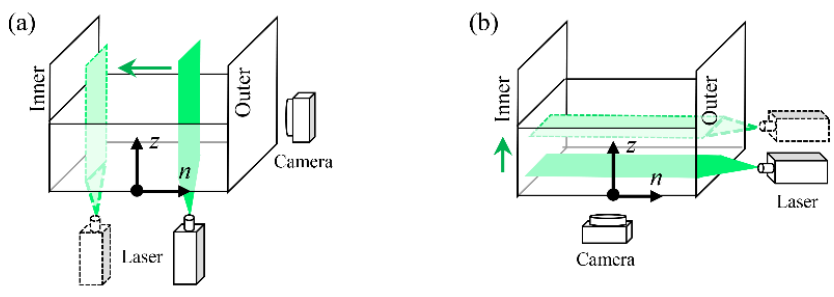
Figure 2. PIV setup with a laser and a camera: ( a ) s-z plane; ( b ) s-n plane.